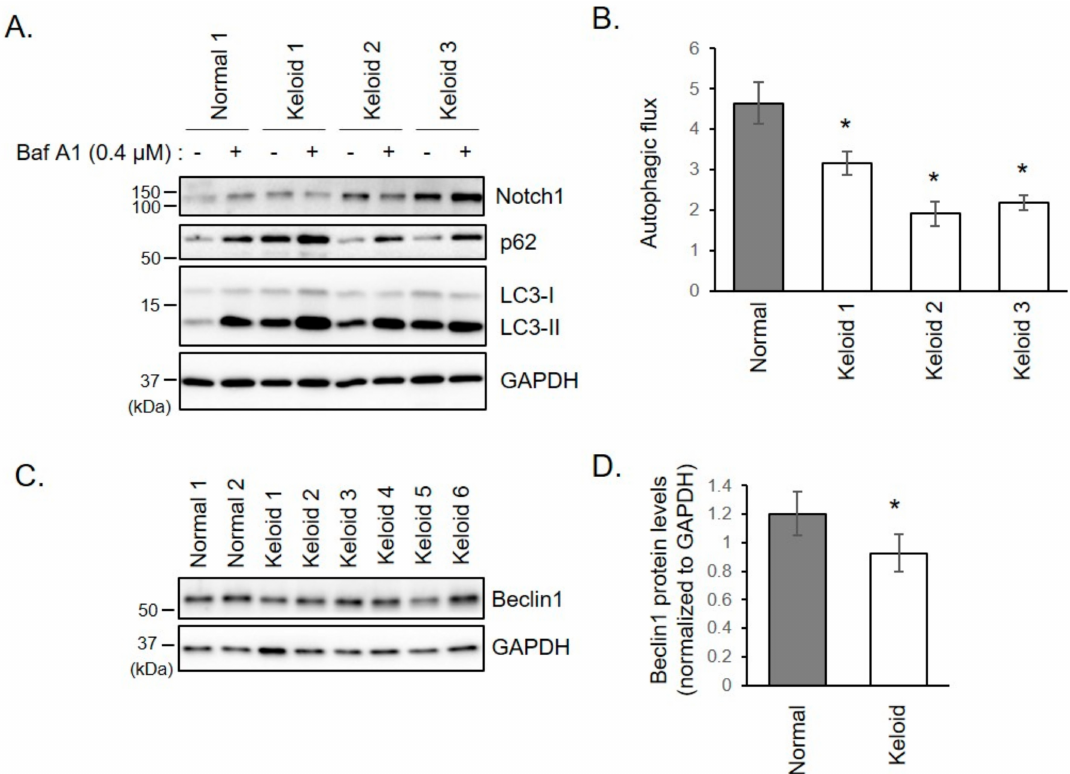
Figure 2. Autophagic flux is reduced in keloid fibroblasts. ( A ) Fibroblast cells were incubated with 0.4 µ M of bafilomycin A1 (Baf A1). After 16 h, cells were analyzed by immunoblotting with indicated antibodies. Autophagic flux was determined by dividing the amount of LC3-II (below 15 kDa) treated with Baf A1 by the amount of LC3-II treated with DMSO. LC3-II bands were normalized to their respective GAPDH bands. ( B ) Graphs show means ± s.d. of five experiments. ( C ) Normal and keloid fibroblasts were lysed and subjected to immunoblotting using Beclin1. Gels are representative of five experiments. ( D ) Graphs show means ± s.d. of five independent experiments. * p <